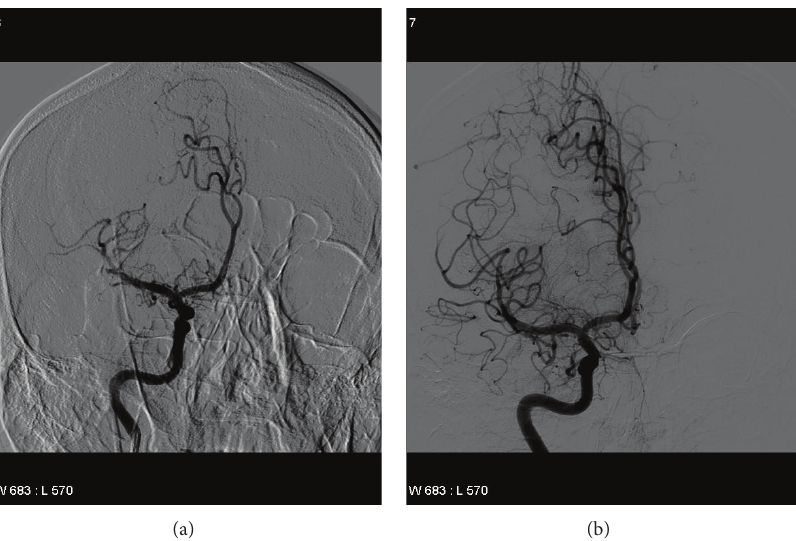
Figure 2: Angiographic appearance of right middle cerebral artery before (a) and after (b) local intraarterial thrombolysis by urokinase (actylise